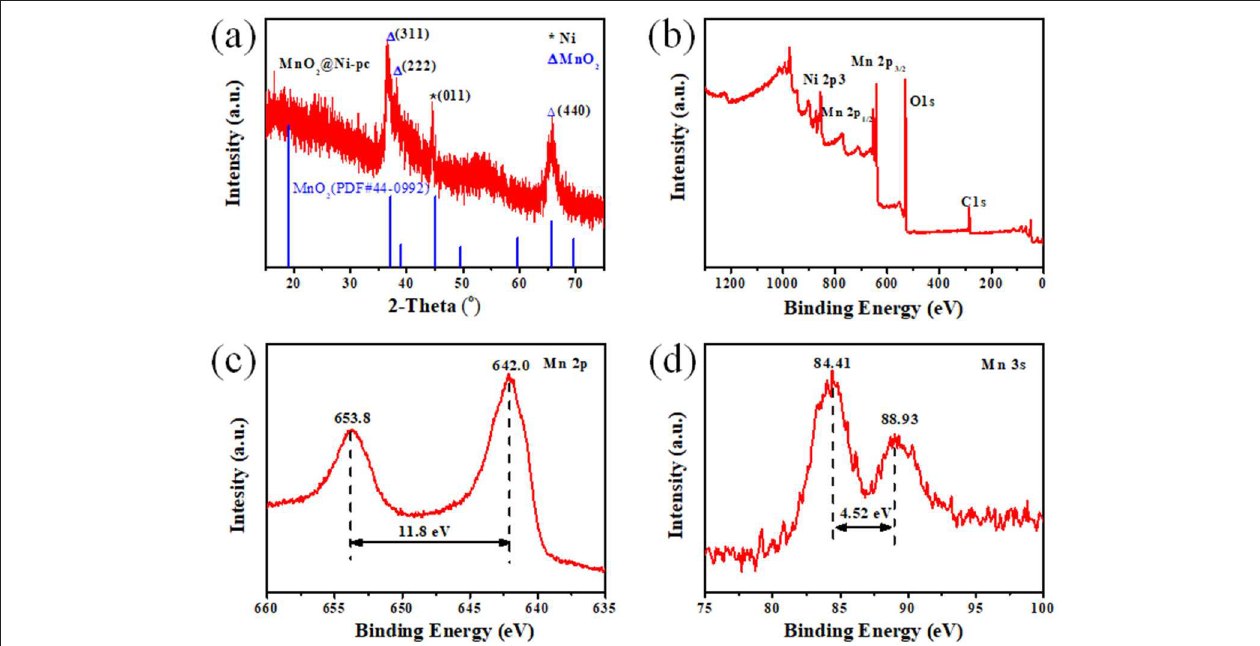
FIGURE 2 | (a) PXRD pattern of MnO 2 @Ni-pc; (b) XPS survey (0–1,300eV) of MnO 2 @Ni-pc; (c,d) High-resolution XPS spectra of (c) Mn 2p and (d) Mn 3s in MnO 2 @Ni-pc.